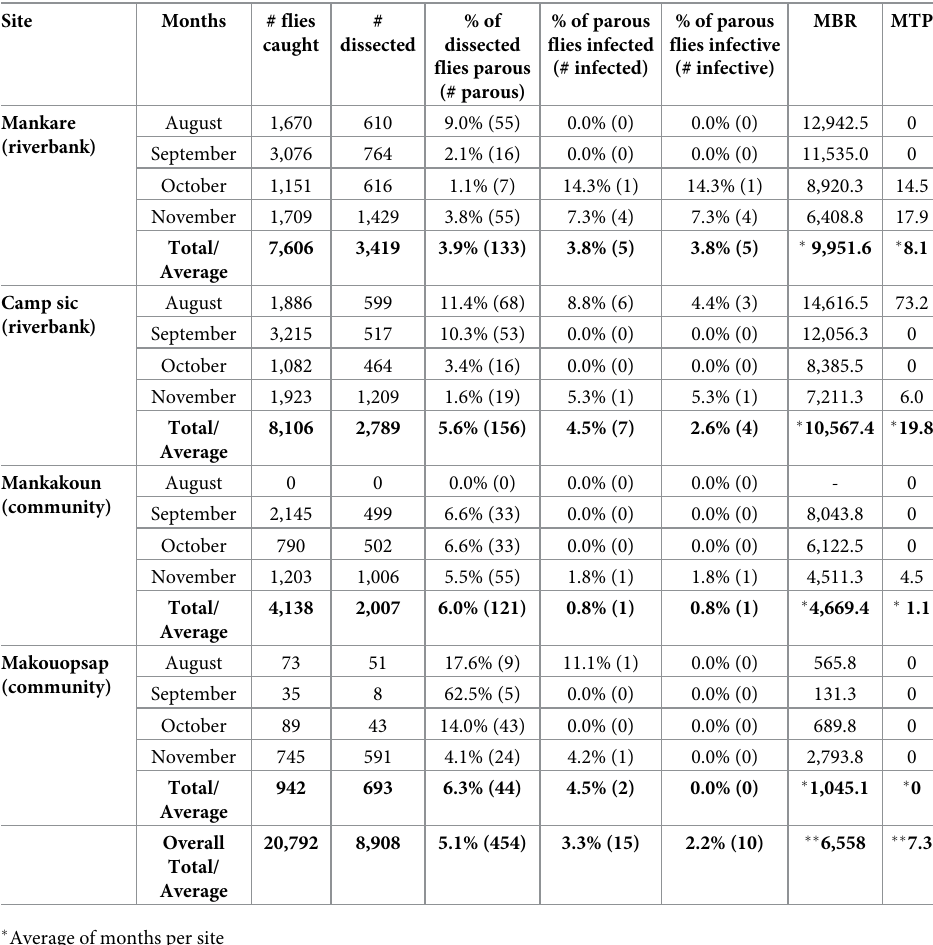
Table 8. Entomological